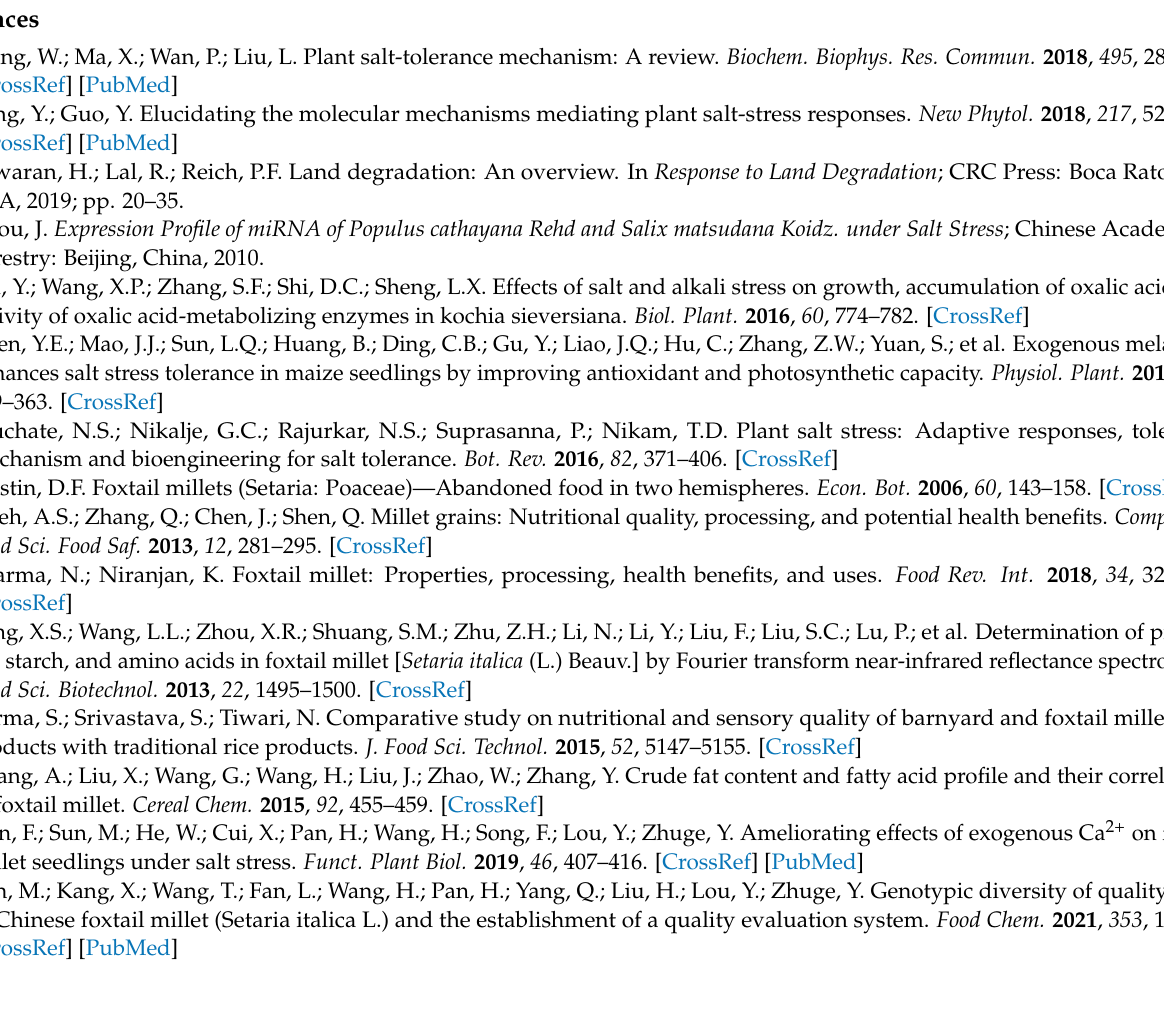
TS/TC. Table S4. DGEs associated with photosynthesis under salt stress. Table S5. DEGs related to transcription factor under salt stress. Table S6. Sequencing statistics of RNA libraries. Table S7. 104 foxtail millet accessions for testing in the